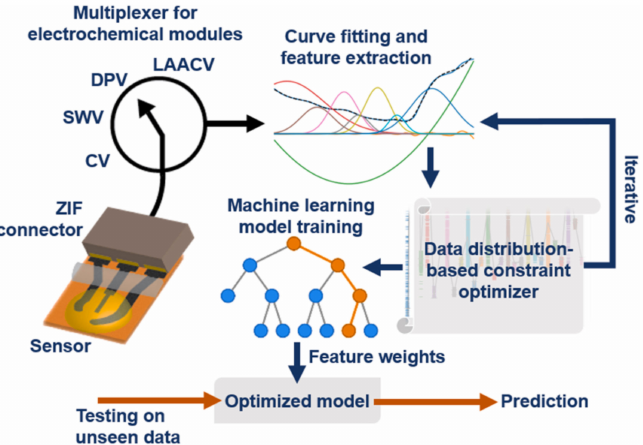
Figure 5. The machine learning-based multi-modal electrochemical analytical system. Reproduced with permission from [17]. Copyright 2022